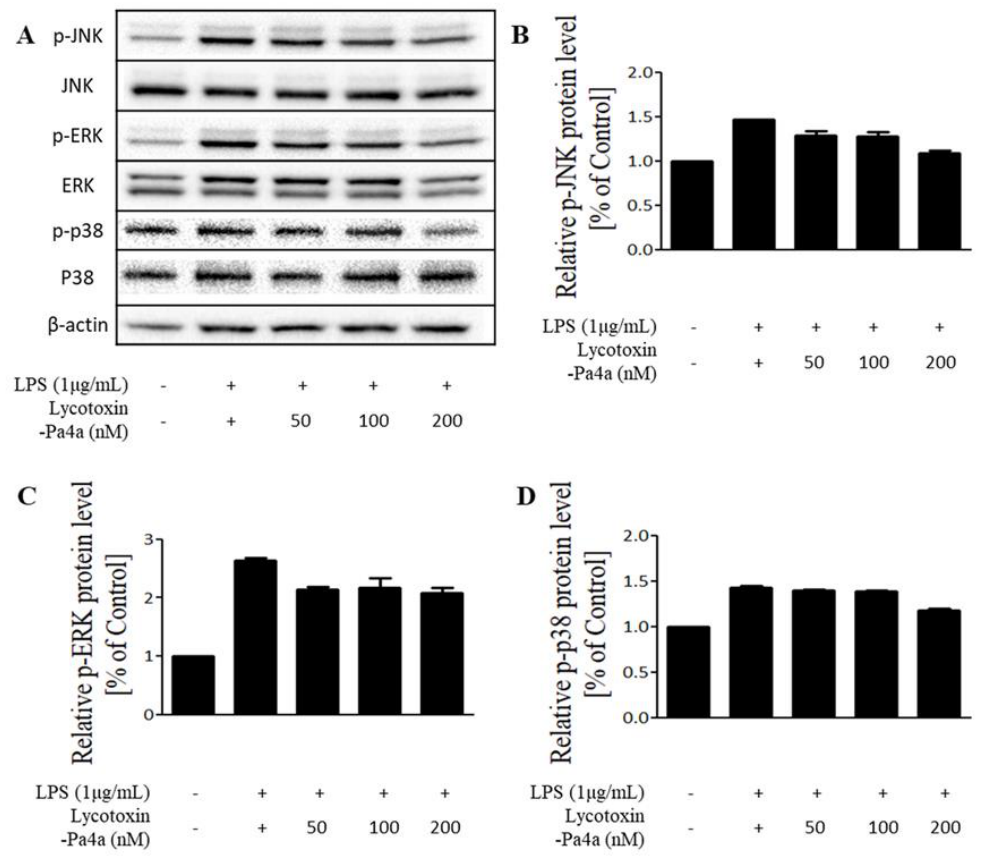
Figure 5. MAPK pathway was inhibited by Lycotoxin-Pa4a.Western blot showed inactivation of JNK, ERK, and p38 ( A ) and the quantified protein expression was shown ( B – D ).